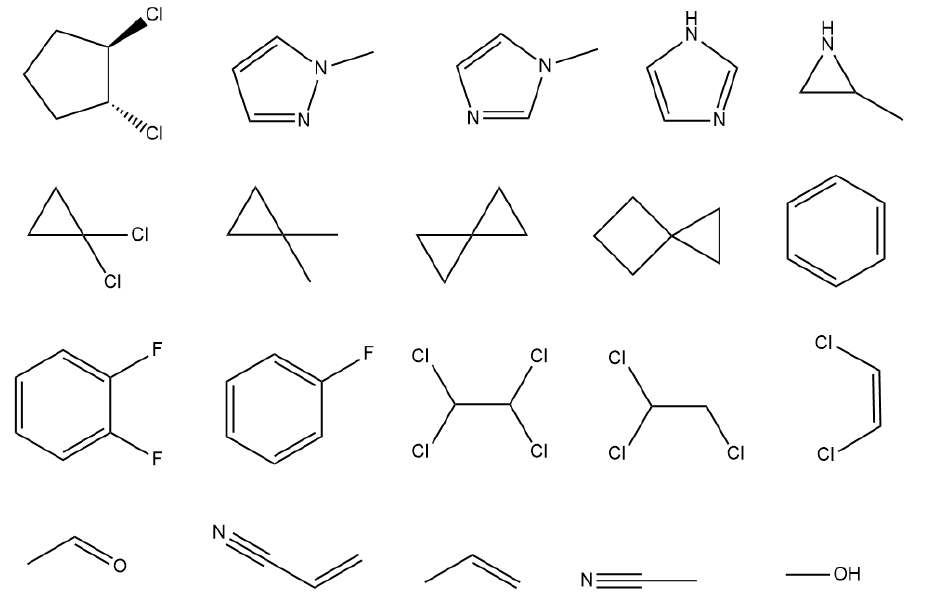
Figure 1. The structures of the 20 molecules used for calculations in this